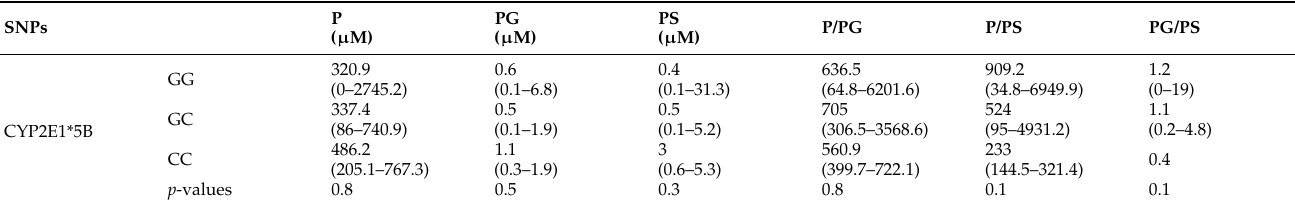
Table 2. Association between the SNPs and serum concentrations of paracetamol and its